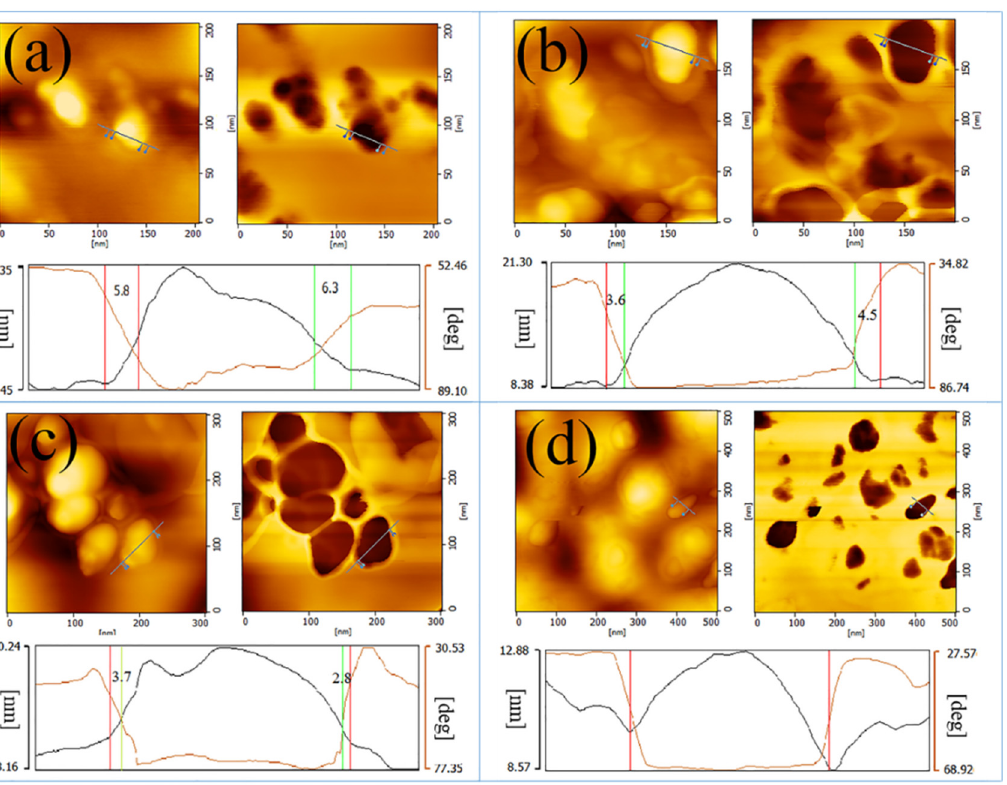
Figure 3. AFM height and phase images of the various CB in NR ( a ) N115, ( b ) N330, ( c ) N550, and ( d ) N660.